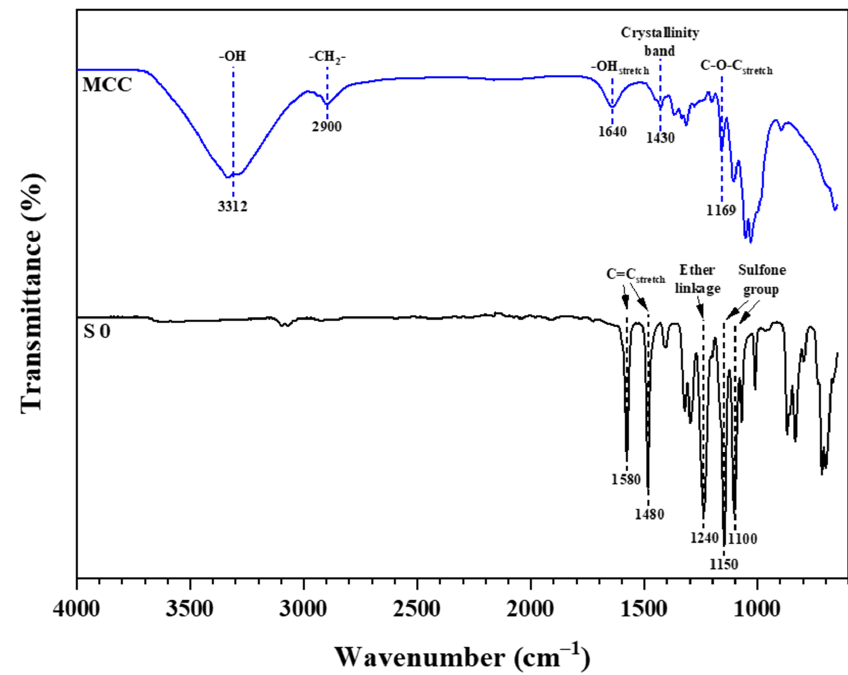
Figure 2. FTIR spectrum of commercial MCC and the pristine PES membrane (S0). Membranes 2021 , 11 , x FOR PEER REVIEW